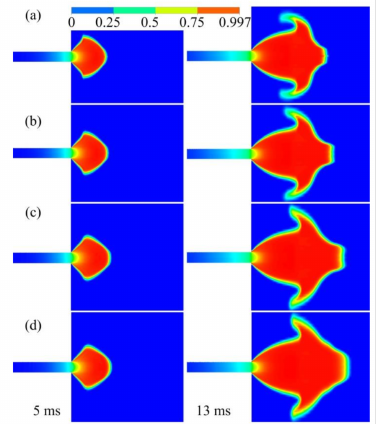
Figure 11. Volume fraction of gas CO 2 with an initial flow velocity of ( a ) 0 m/s, ( b ) 2.5 m/s, ( c ) 5 m/s and ( d ) 10 m/s. The flow time of the left picture was 5 ms, and the flow time of the right picture was 13